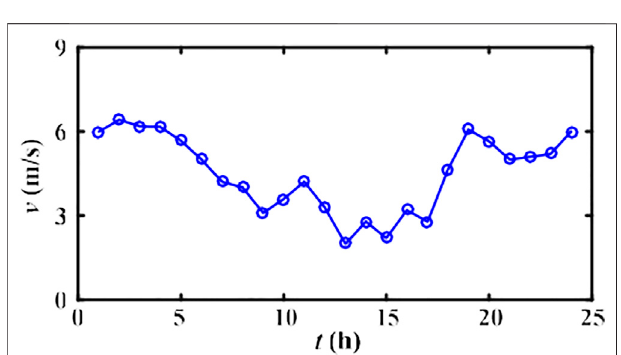
FIGURE 11 | Daily wind velocity